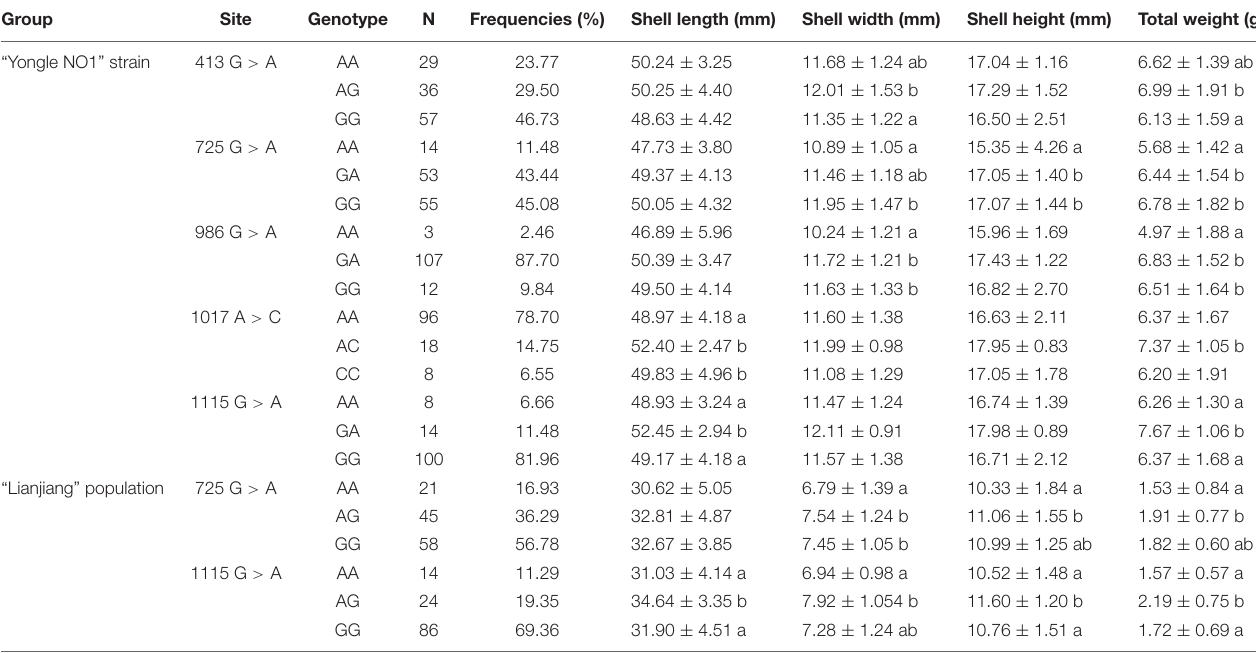
Different letters represent significant differences, P < 0.05.